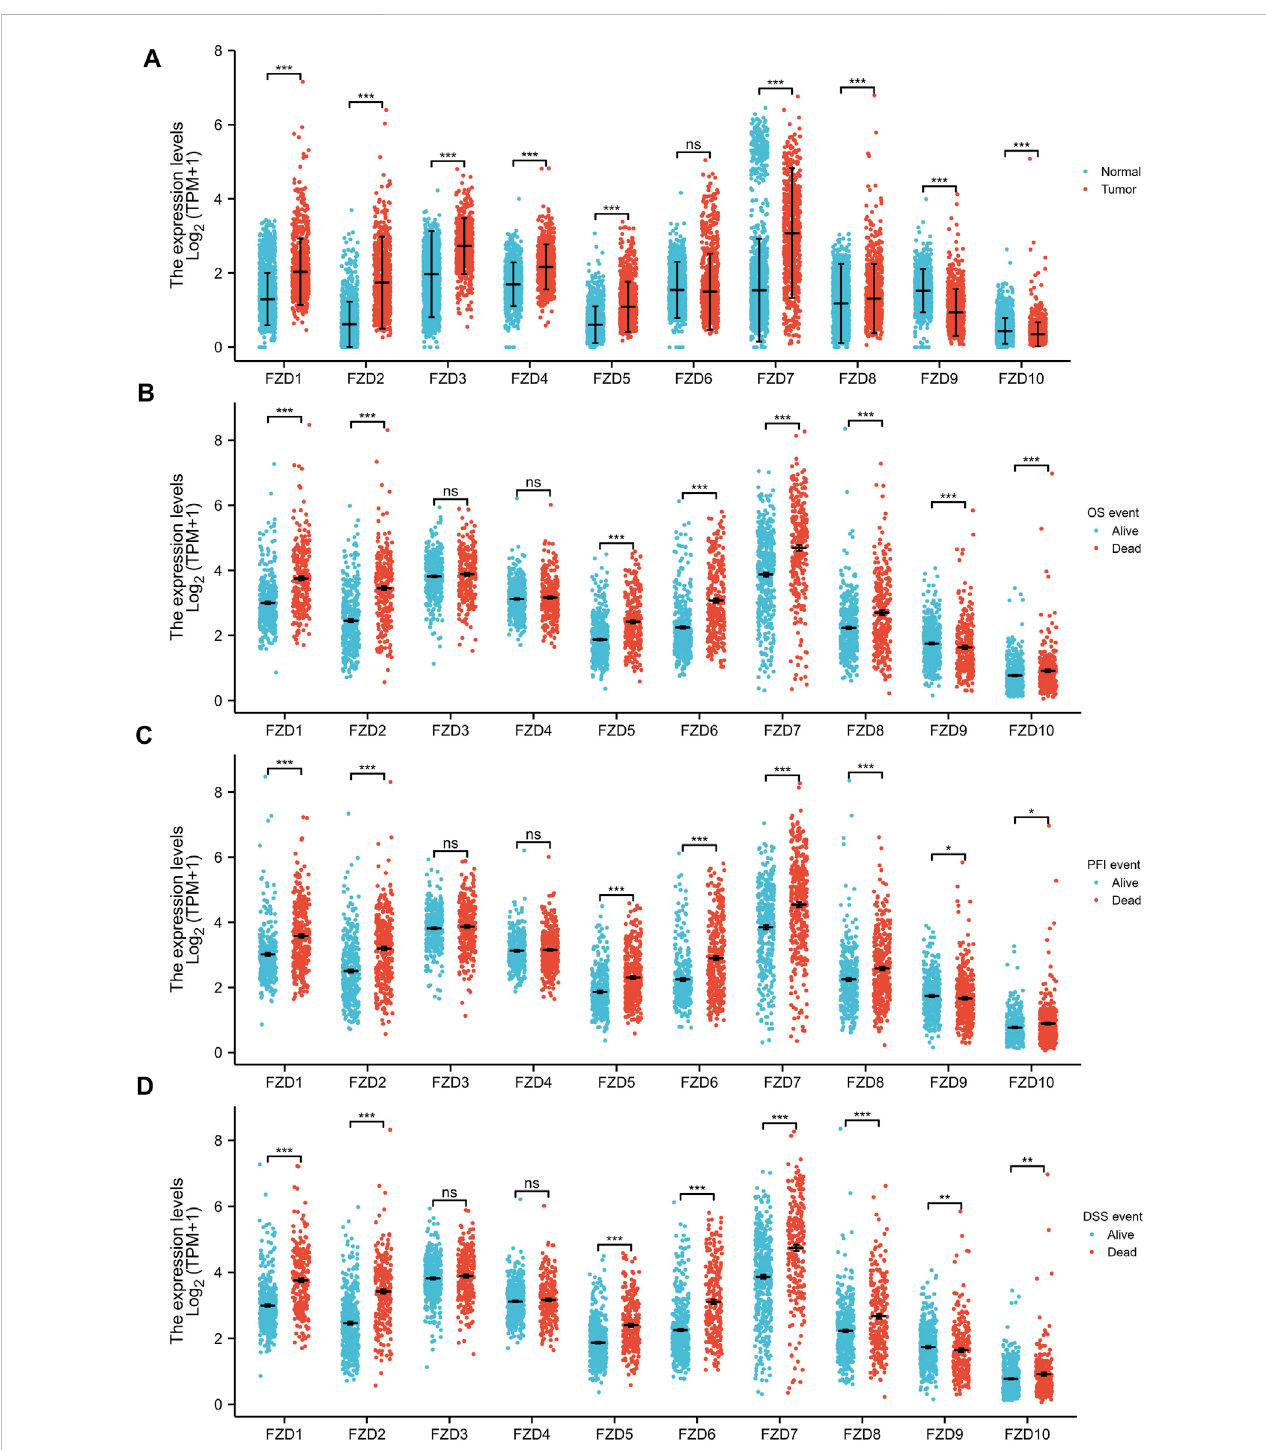
FIGURE 1 Wilcoxon rank sum test of differentially expressed genes (DEGs). (A) Gene expression levels of FZDs in normal tissues and gliomas. (B – D) Correlation between FZD expression and the overall survival event (OS event), progression-free interval event (PFI event), and disease-free survival event (DSS